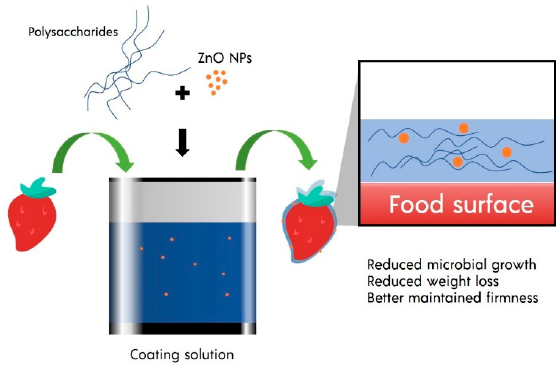
Figure 1. ZnO NPs in the polysaccharide-based safe coating.